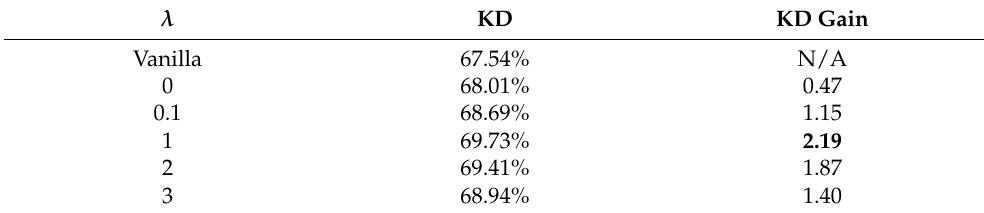
Table 9. Impact of the KD loss weight.(best results represented in